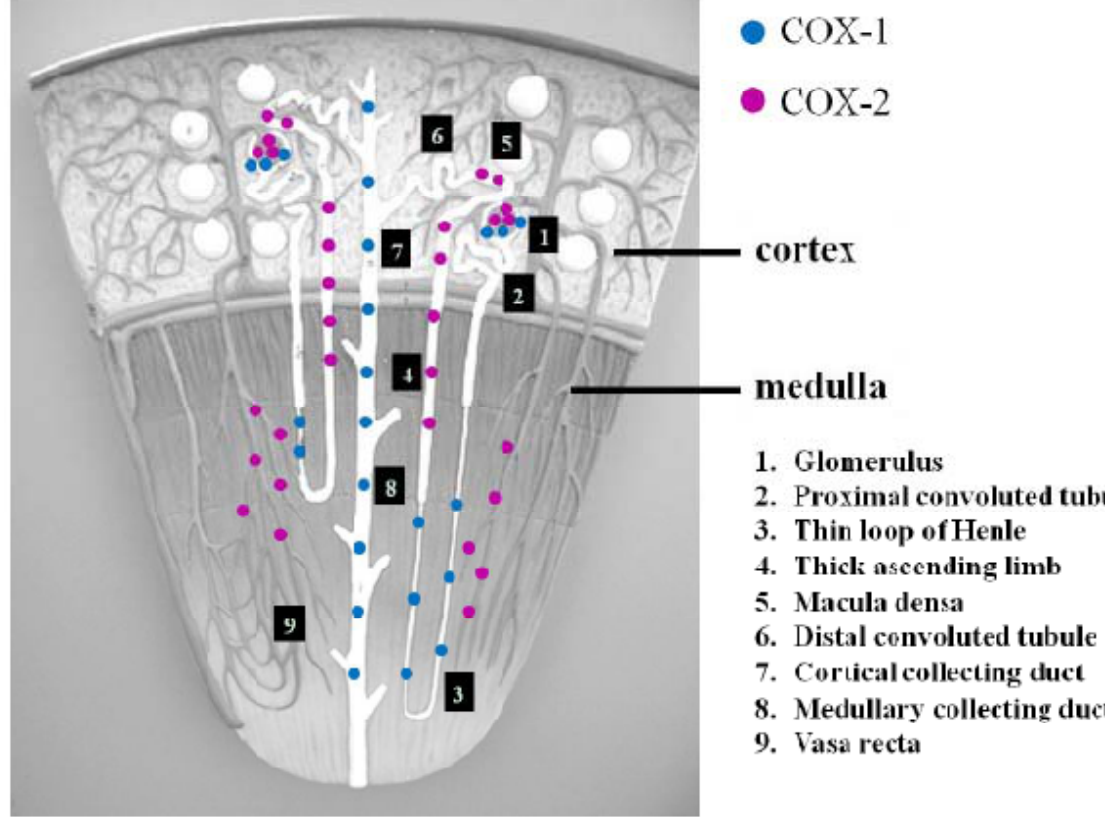
Figure 2. Distribution of COX isoforms in the adult